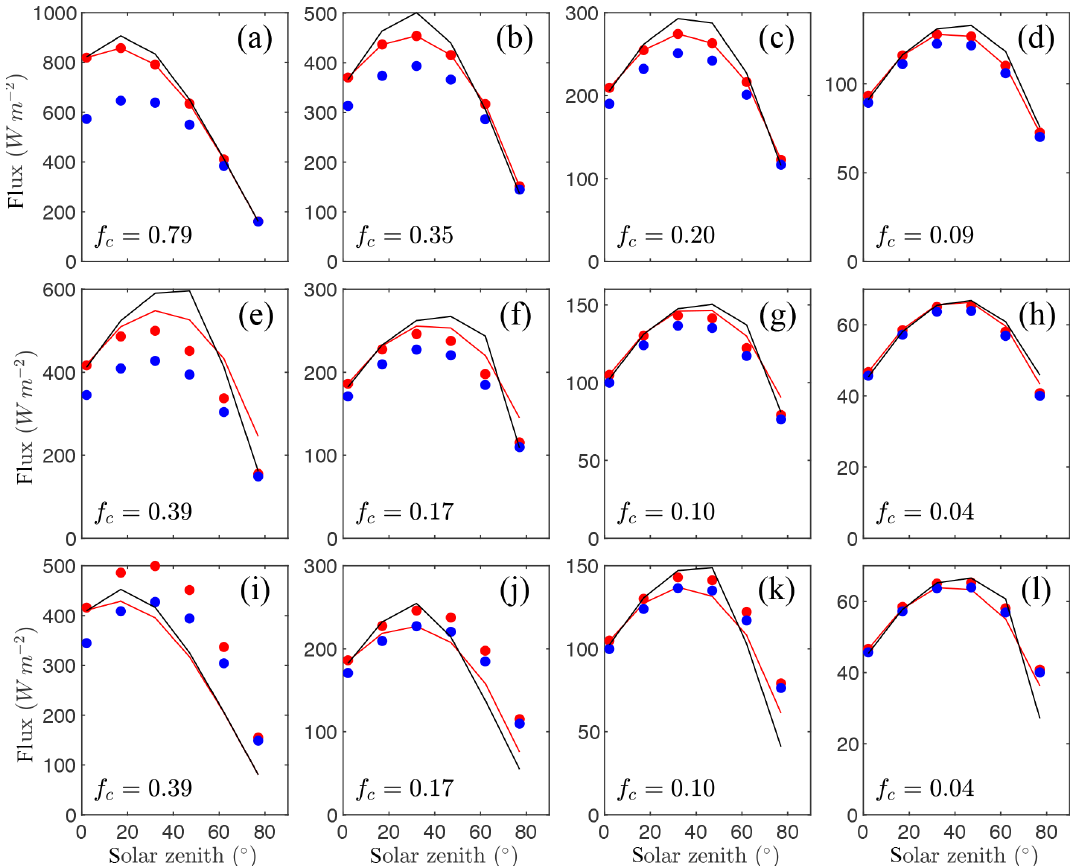
Figure 5. Flux of intercepted radiation versus solar zenith angle for a half-diurnal cycle in a canopy of solid cylinders (see Fig. 3b). Varying ground cover fractions f c were simulated (rows in figure) for three different plant arrangements: (a–d) randomly spaced, (e–h) east–west row orientation, and (i–l) north–south row orientation. The exact flux is given by the output of the 3-D model (black line), which is compared against the 1-D models BINOM (red line), NIL99_B (red circle), and NIL99_P (blue circle).